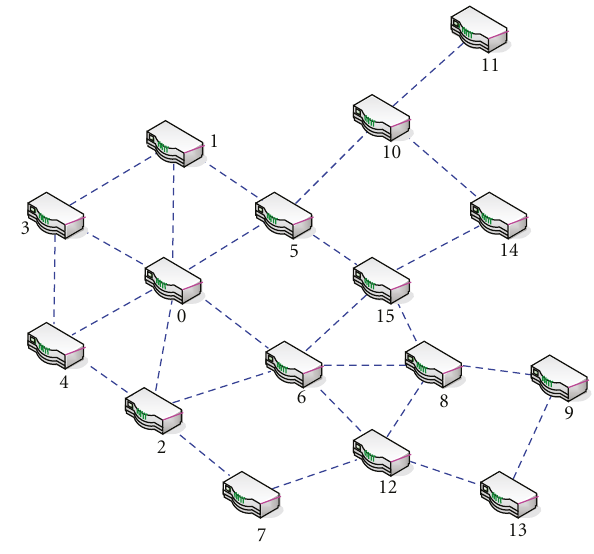
Figure 7: A random network topology.